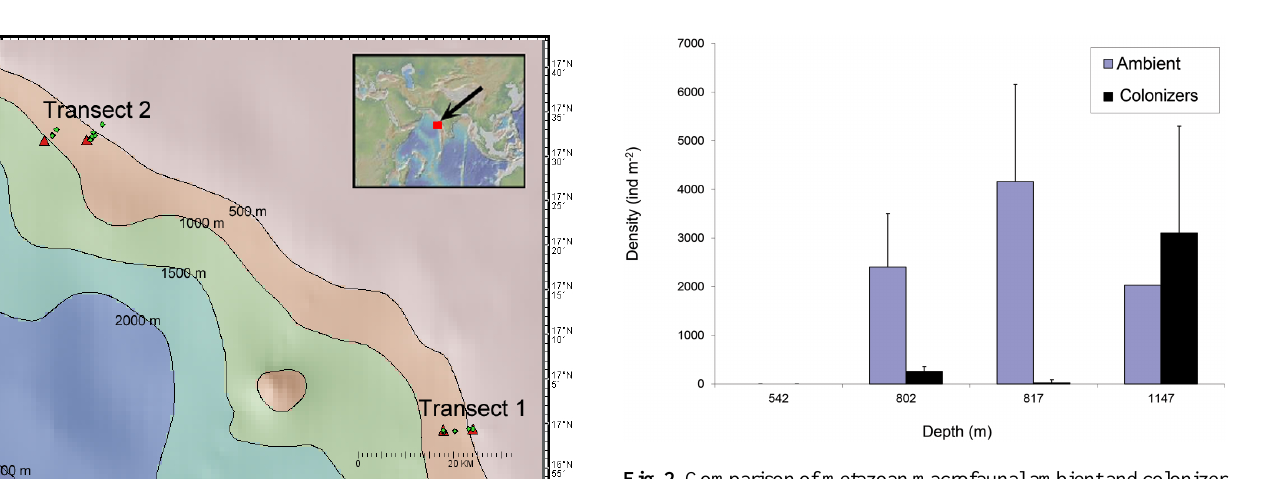
Fig. 2. Comparison of metazoan macrofaunal ambient and colonizer average density ( ± 1 SD) on the W. Indian margin. See Table 1 for tray deployment periods and